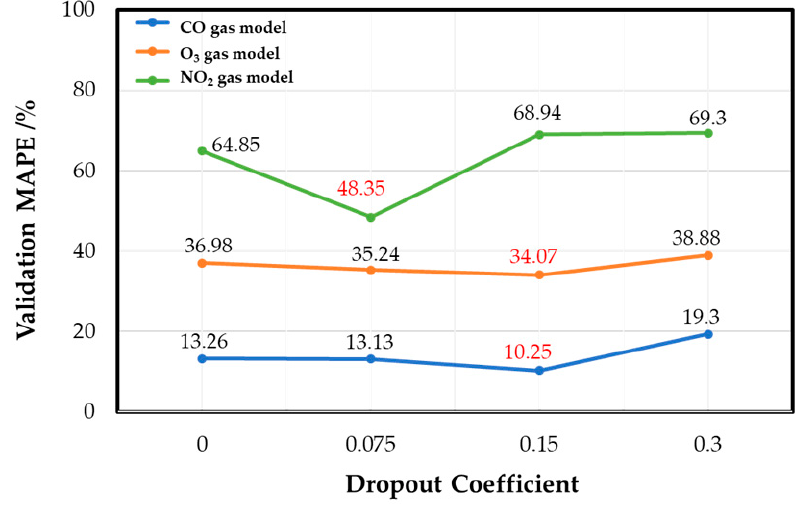
Figure 11. Dropout coefficient effect of each gas model.